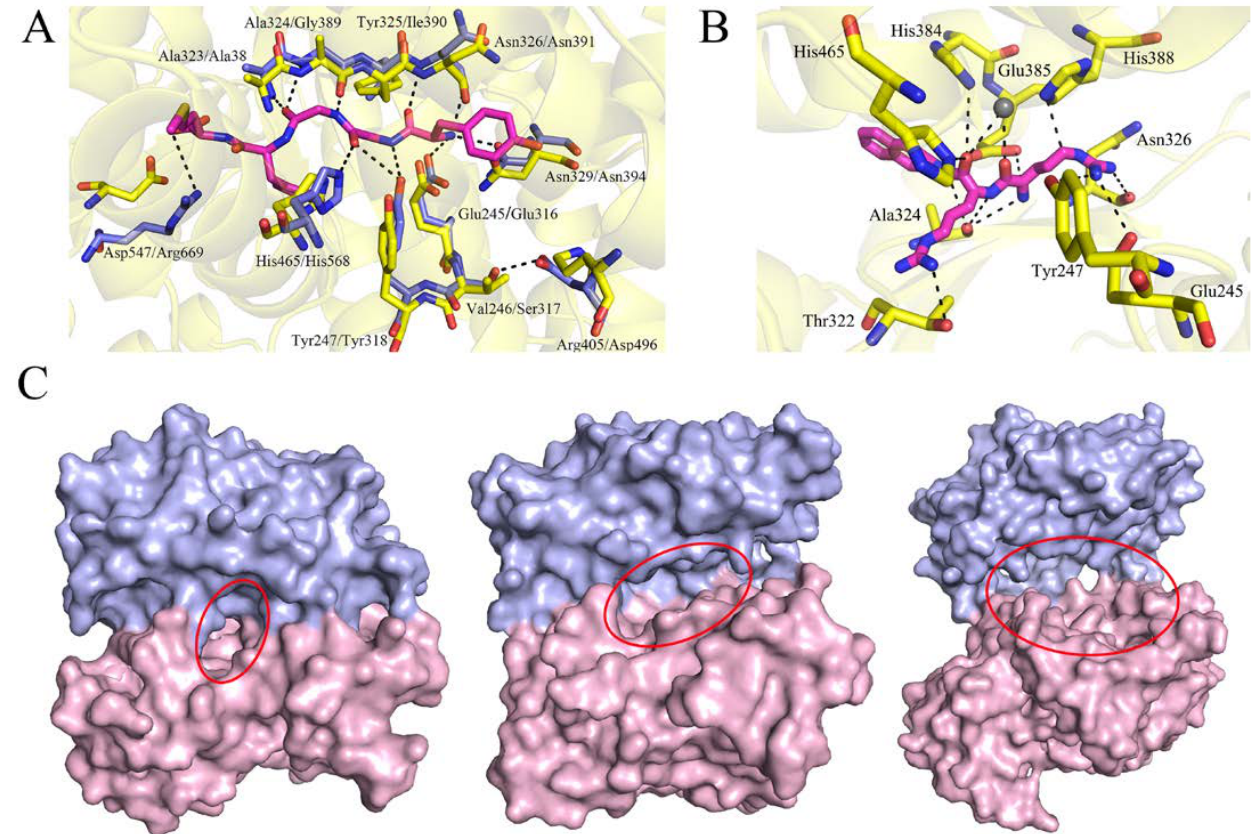
Figure 8. Substrate binding site of Co DPP III. ( A ) Structure overlay of Co DPP III (yellow) and the substrate binding site of h DPP III complex (light blue, PDB ID: 5E33). The hydrogens between the amino acids of h DPP III and Met-enkephalin (magenta) are shown as black dash lines. ( B ) Interaction between the docked Arg 2 -2NA (magenta) and the amino acids in the binding site of Co DPP III (yellow). The hydrogens are shown as black dash lines. The catalytic zinc ion and water are represented by a gray sphere. ( C ) Surface representations of Co DPP III (left), Ca DPP III (middle, PDB ID: 6EOM), and Bt DPP III (right, PDB ID: 5NA7). The upper and lower domains are shown in light blue and pink. The substrate binding sites are marked by red ellipse.